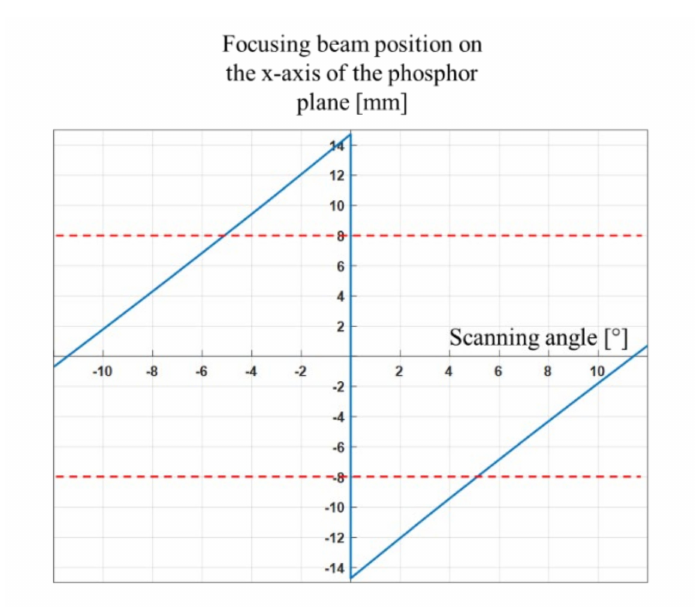
Figure 6. Focusing beam position in x -axis of phosphor plane according to scanning angle. Dashed red lines represent effective area of x -axis of phosphor plane.